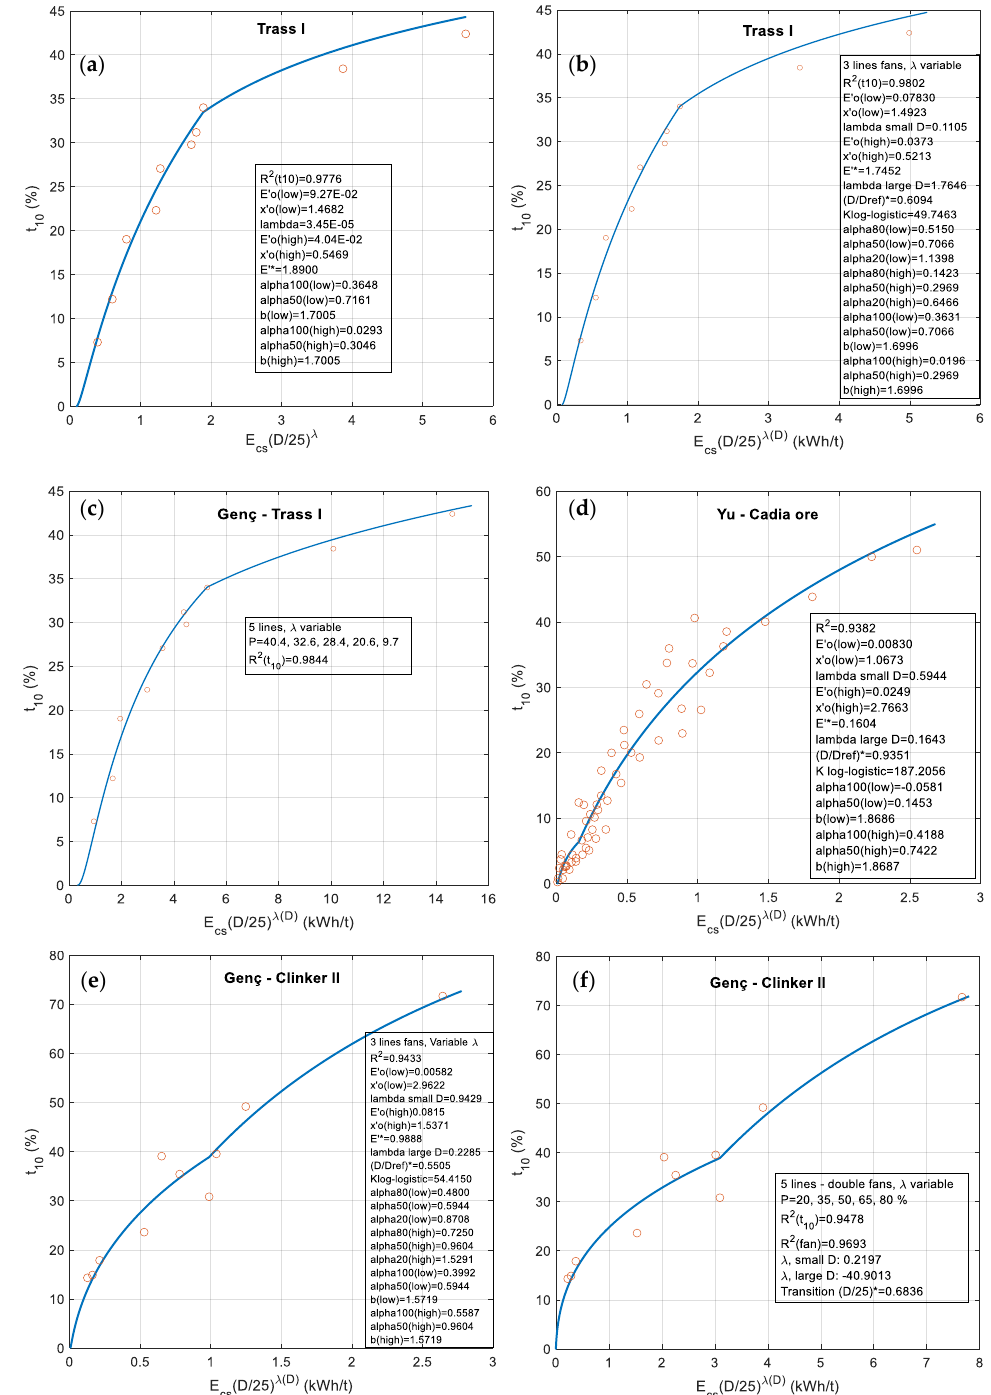
Figure 11. BIEs. ( a ) trass I, basic double fan ( 𝑅 2 = 0.9776); ( b ) trass I, double fan I-2 ( 𝑅 2 = 0.9802); ( c ) trass I, double fan I-4 ( 𝑅 2 = 0.9844); ( d ) Cadia ore double fan I-2 ( 𝑅 2 = 0.9382), BIE for basic double fan may be seen in Appendix B ( 𝑅 2 = 0.9313); ( e ) clinker II, double fan I-2 ( 𝑅 2 = 0.9433); ( f ) clinker II, double fan I-3 ( 𝑅 2 = 0.9478), BIE for basic double fan may be seen in Figure 9 ( 𝑅 2 = 0.9387).